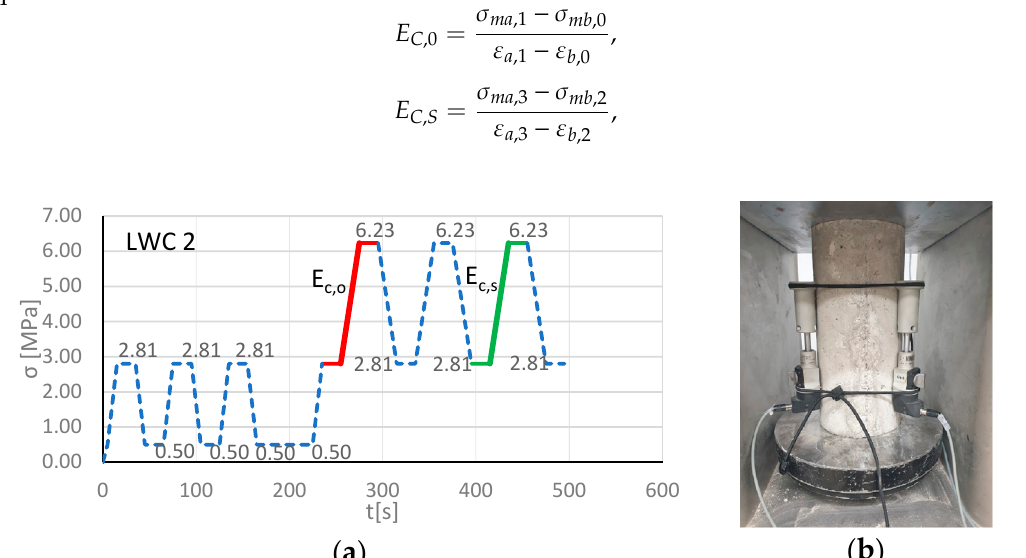
Figure 4. ( a ) The scheme of cyclic loading according to Method A [57] where LWC 2 is shown as an example: σ p = 0.5 ( MPa ) , σ b = 2.81 ( MPa ) ,and σ a = 6.23 ( MPa ) ; ( b ) the specimen during the testing of the modulus of elasticity.